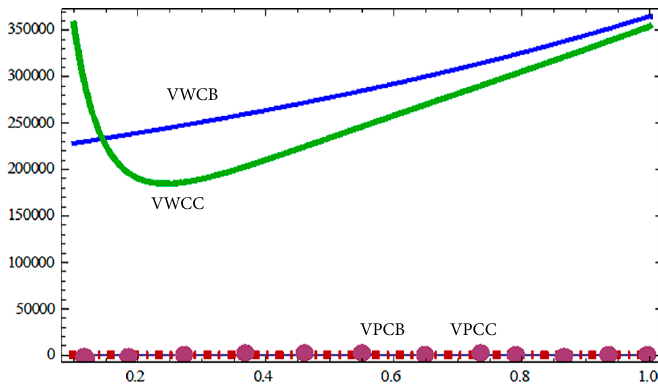
Figure 3. Comparison of cluster